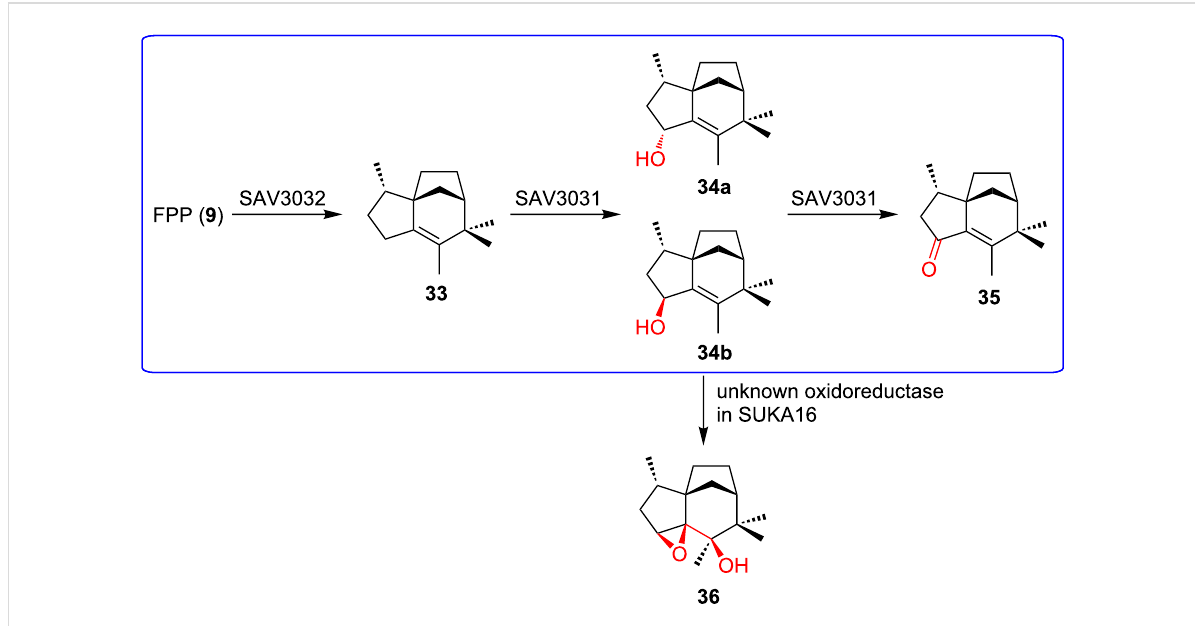
Figure 8: Off-target effects observed during heterologous expression of terpenoid BGCs. Unexpected oxidation of 34b by an oxidoreductase in the heterologous host S. avermitilis SUKA16. The native pathway is highlighted in blue.